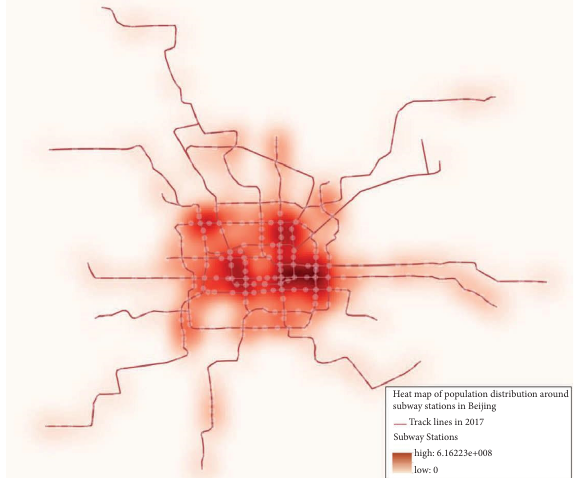
Figure 8: Heat map of population distribution around subway stations in Beijing.